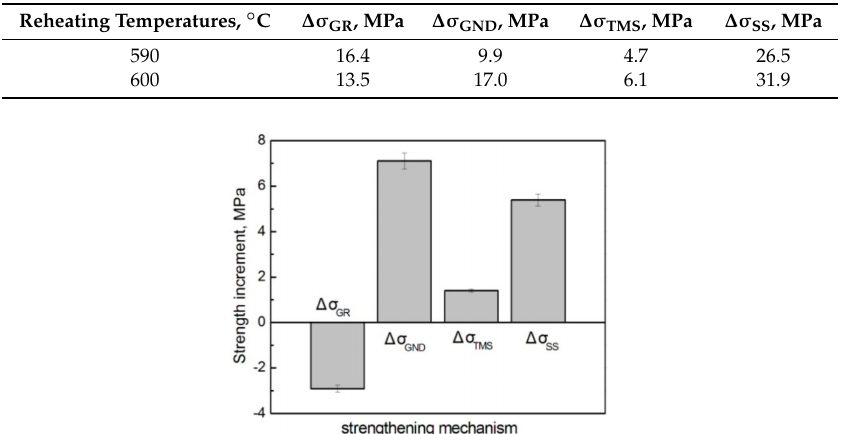
Table 5. Calculated values of ∆ σ GR , ∆ σ GND , ∆ σ TMS , and ∆ σ SS according to Formulas (2)–(5) for the composites thixoformed at reheating temperatures of 590 ◦ C and 600 ◦ C.